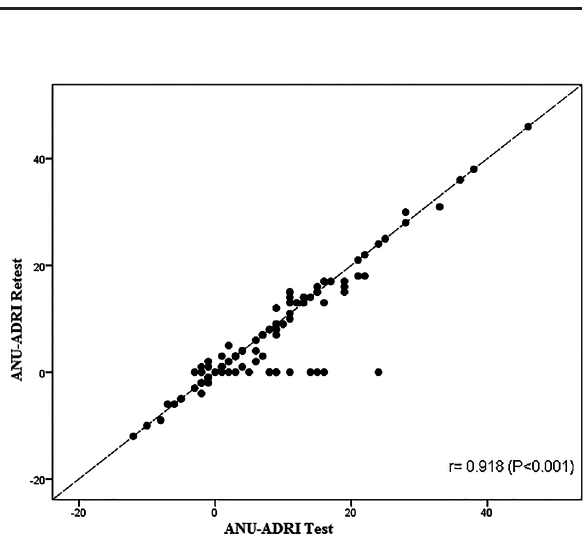
Figure 2. Dispersion plot of relationship between ANU-ADRI Test and